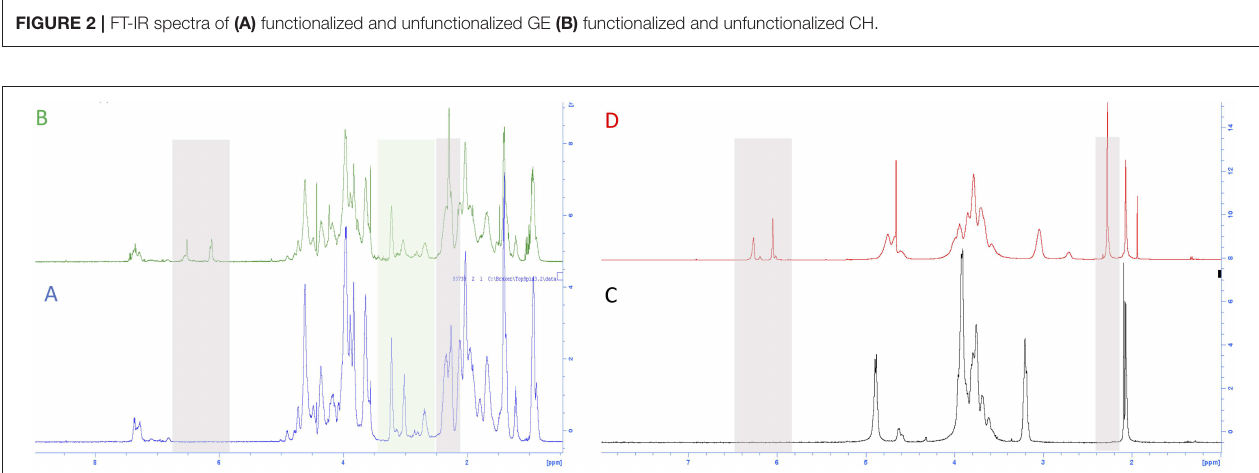
FIGURE 3 | 1 H NMR spectra of (A) gelatin control (GE), (B) functionalized gelatin (GE-5MF), (C) chitosan control, and (D) functionalized chitosan